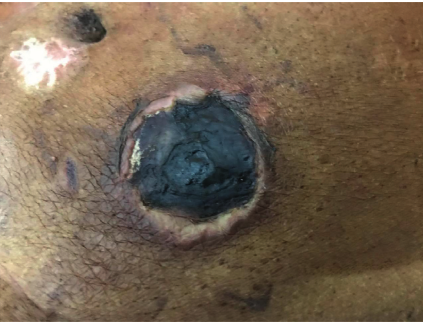
Figure 1: Necrotic nodular lesion on the anterior abdominal wall.